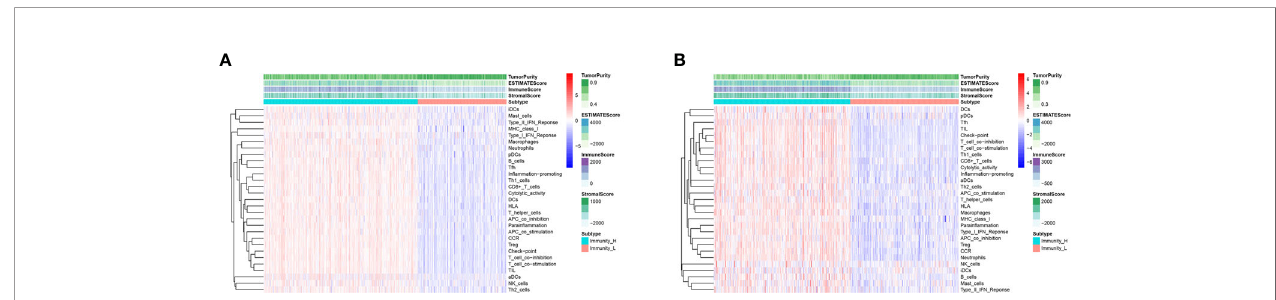
FIGURE 2 | Unsupervised Cluster Analysis Identi fi ed two CRC subtypes. (A, B) Two immune subtypes, namely Immunity High (Immunity_H) and Immunity Low (Immunity_L), were yielded by the hierarchical clustering from the TCGA (A) and GEO GSE39582 (B)